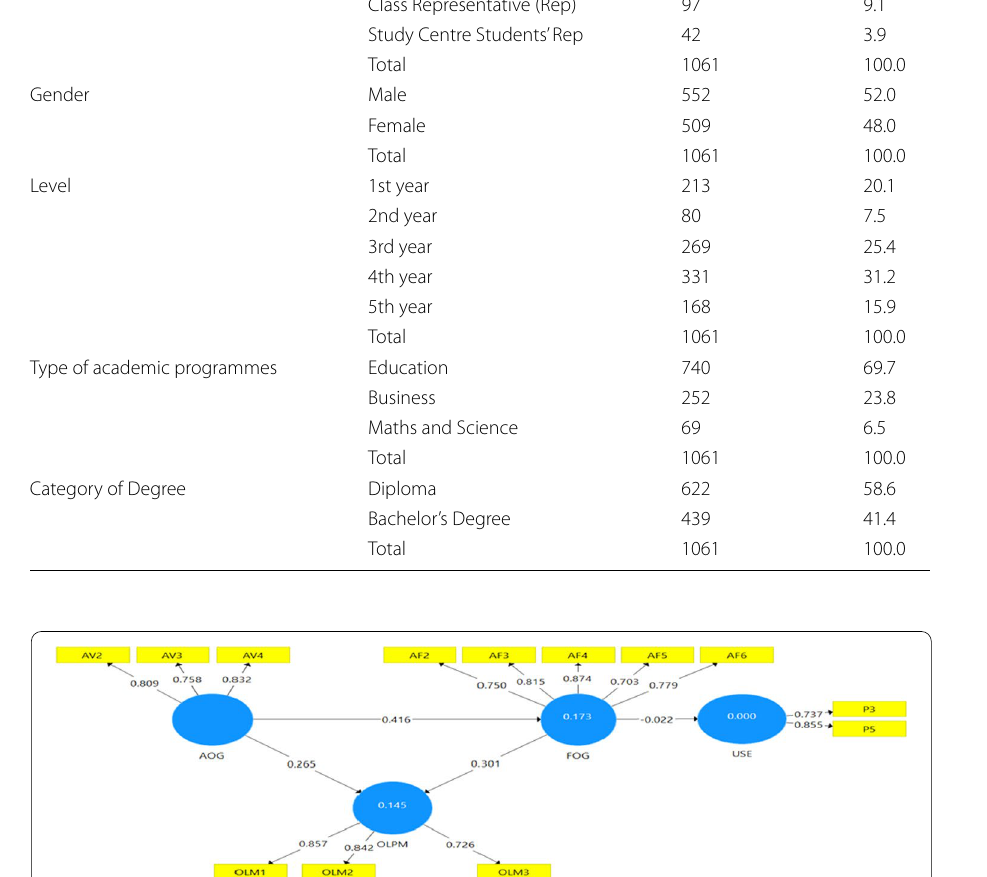
Table 1 Demographic characteristics of students. Source : Field survey (2021), N Variables